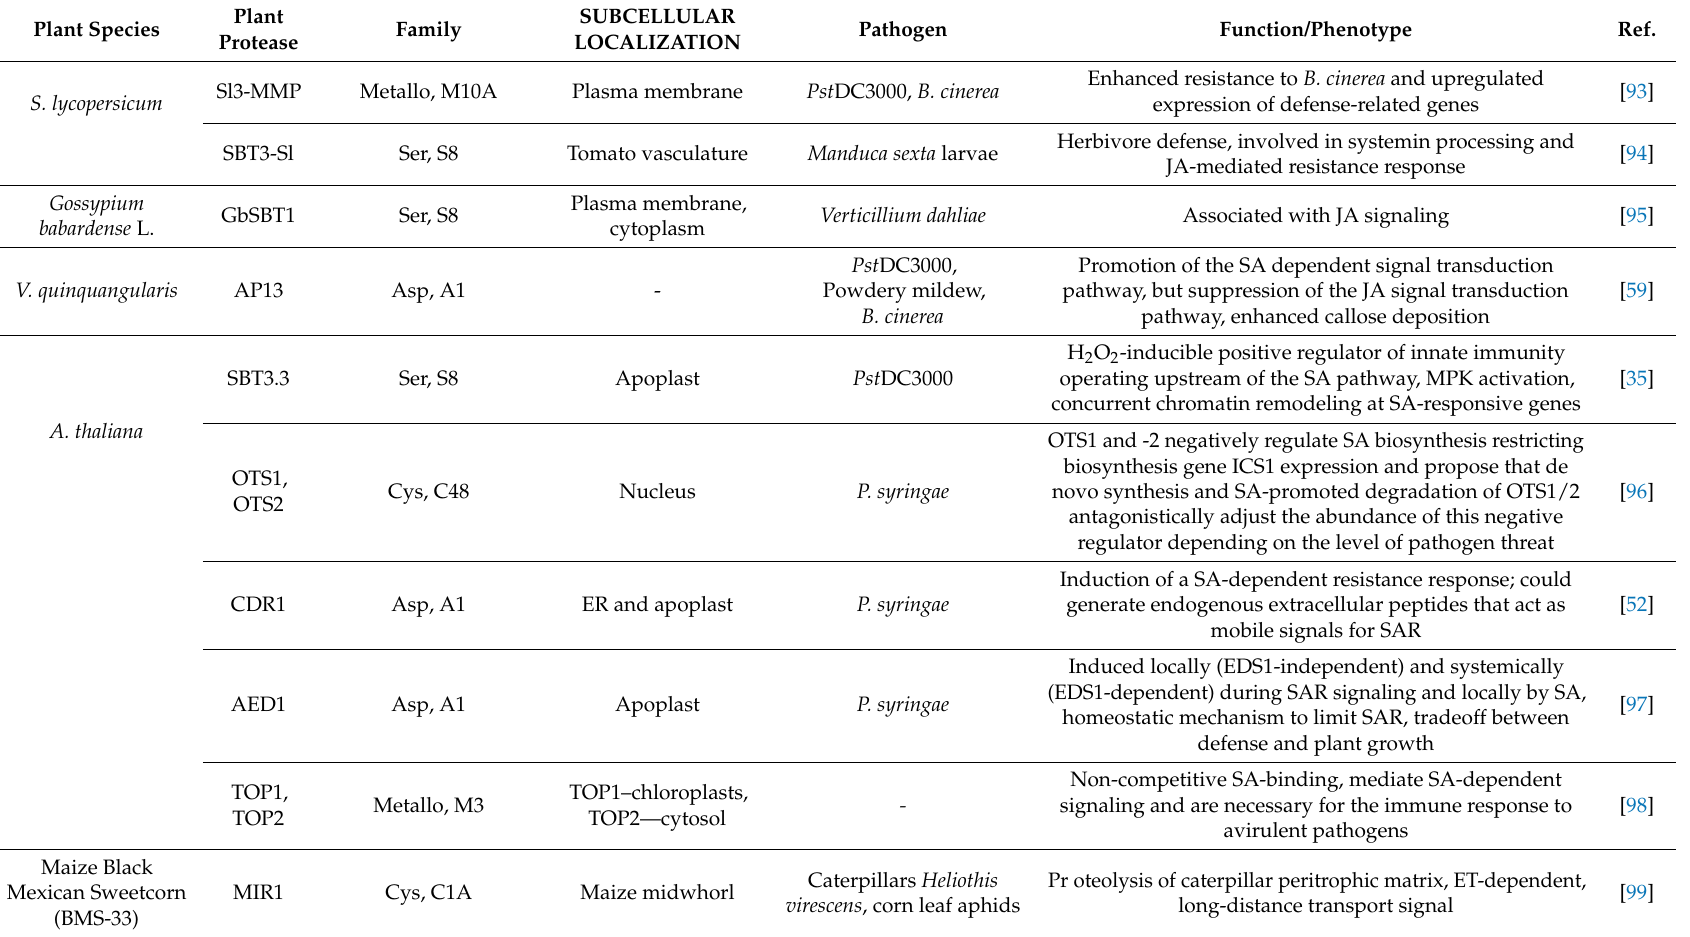
Table 2. Proteases involved in MTI/ETI downstream pathways, SAR and